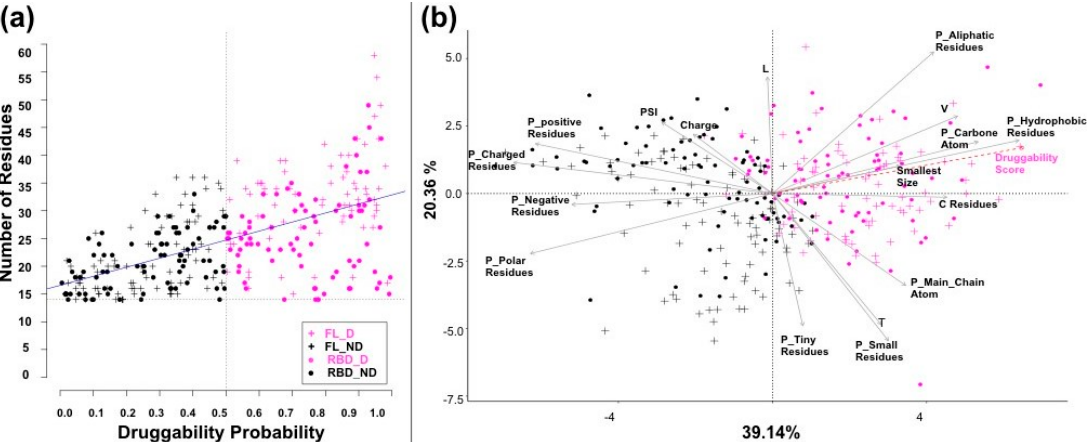
Figure 4. Pocket druggability and principal component analysis (PCA). ( a ) The scores of the 323 groove-pockets plotted against their number of residues (correlation value of 0.57, p -value < 2.2 × 10 − 16 ). ( b ) Two-dimensional projection of the 17 descriptors onto the first two PCA axes. The druggable pockets (druggability score ≥ 0.5) are in violet, and the others are in black. Crosses correspond to FL pockets, and dots correspond to the RBD pockets.